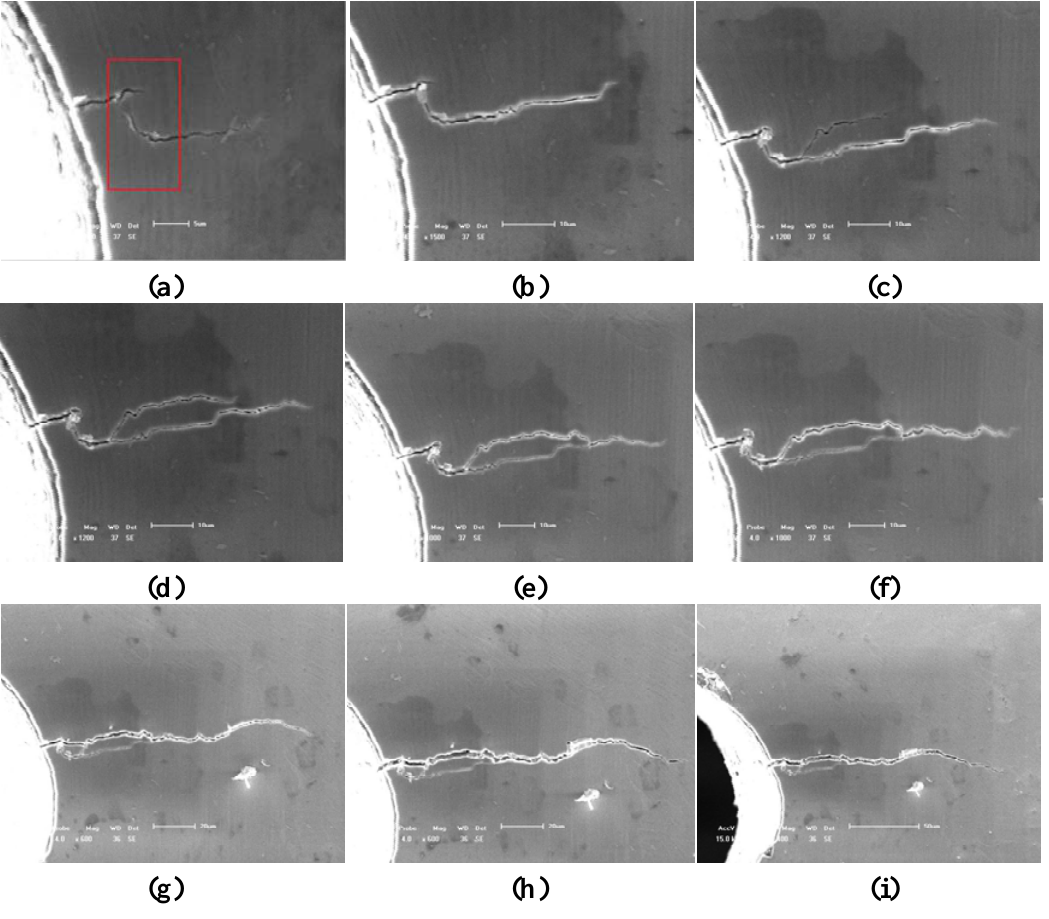
temperature under different cycles of the same applied stress of 345 MPa. ( a ) N = 16,400, (bar scale 5  m); ( b ) N = 31,400, (bar scale 10  m); ( c ) N = 45,604, (bar scale 10 